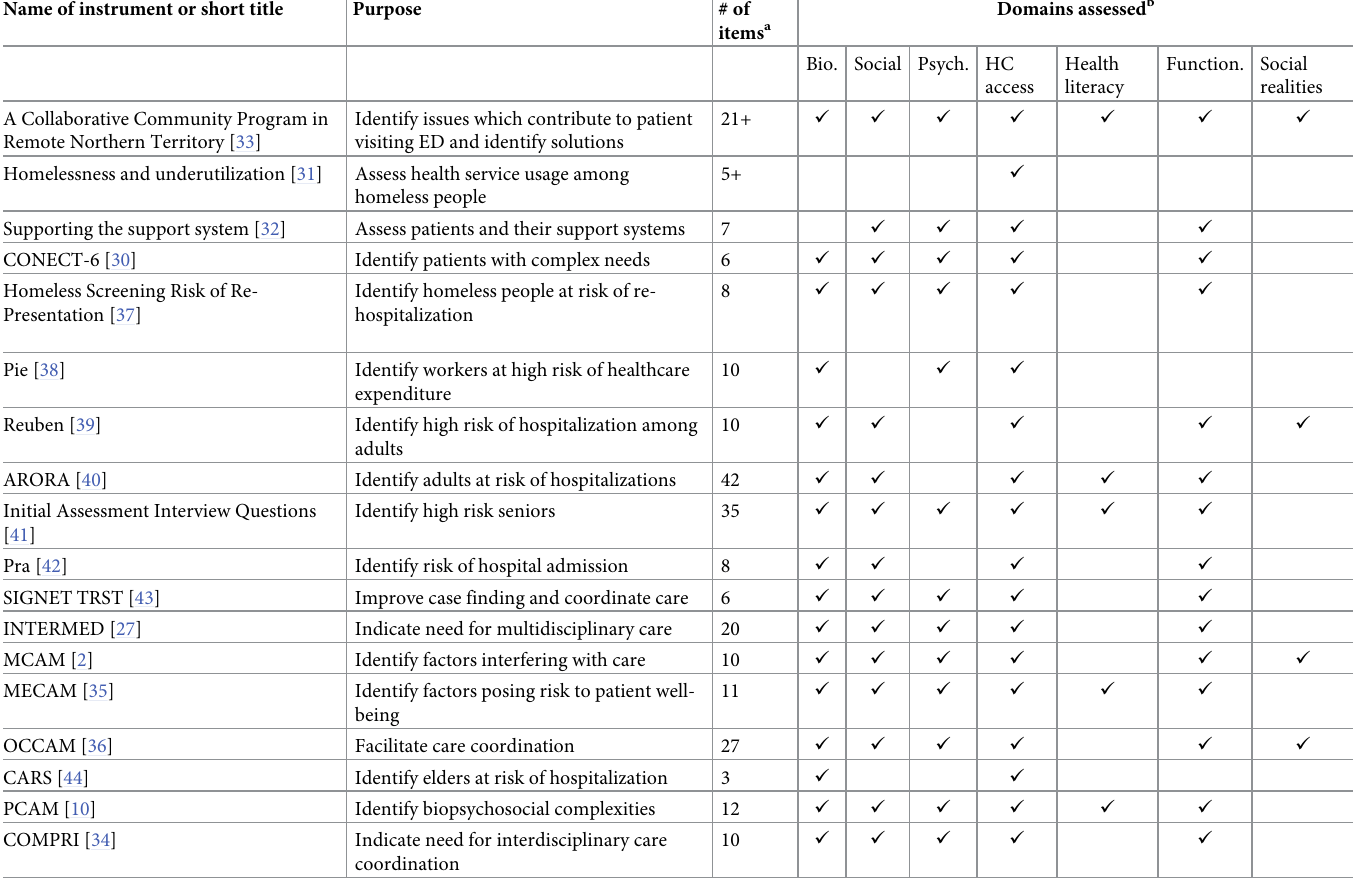
Table 2. Domains assessed by identified tools and